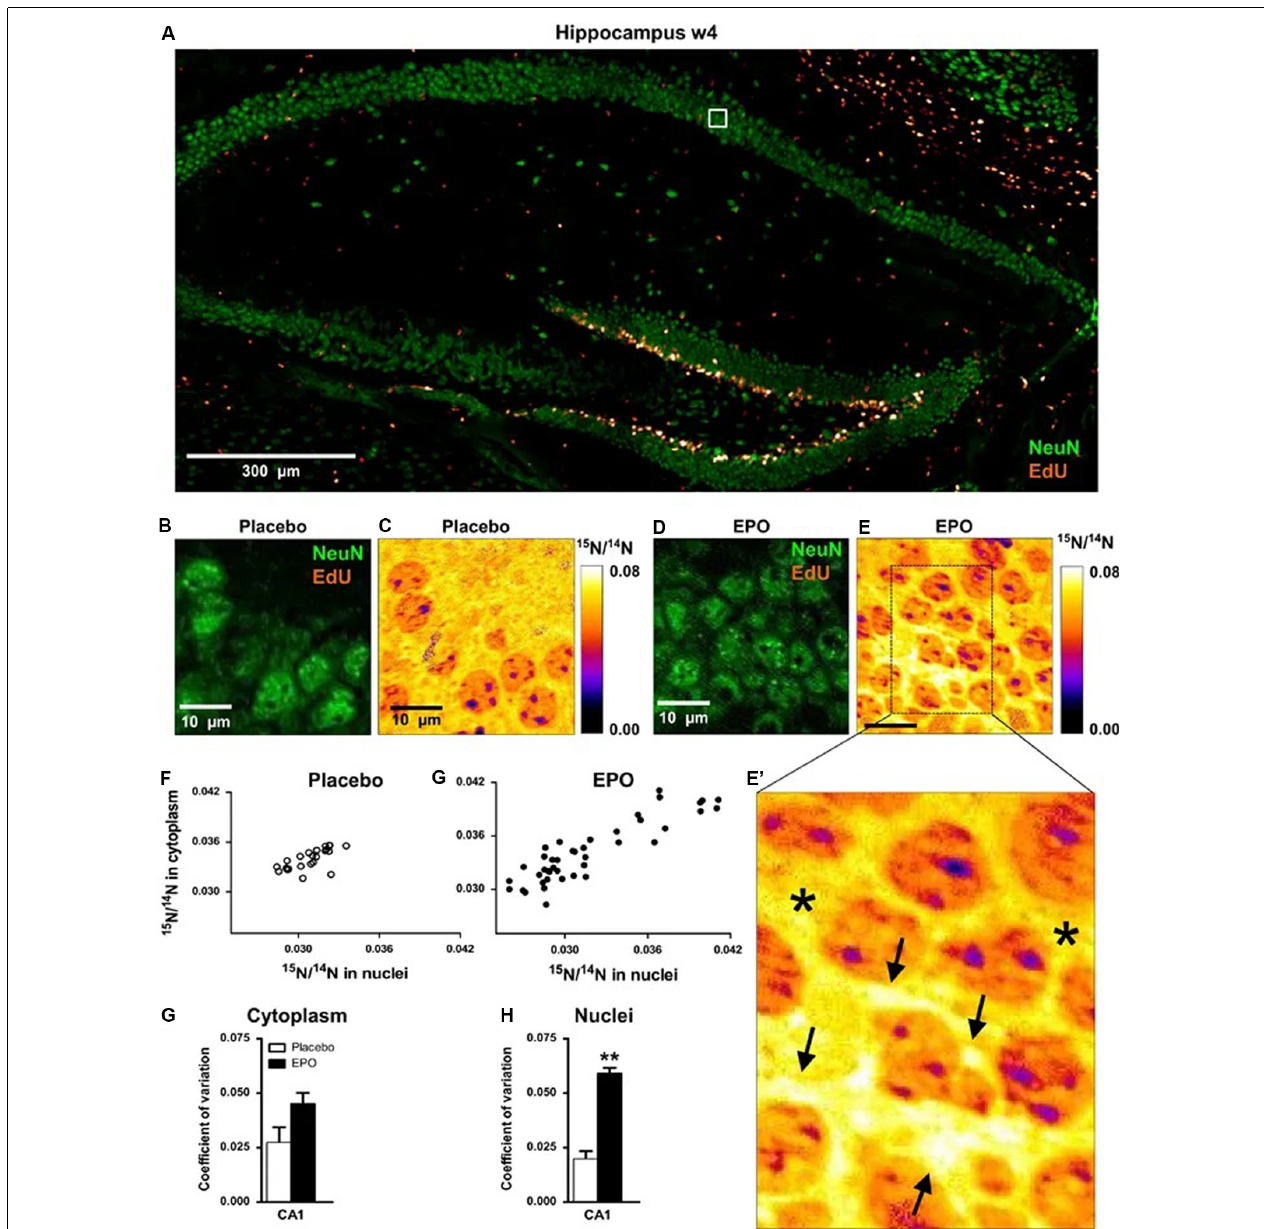
FIGURE 4 | 15 N-leucine incorporation in CA1 pyramidal neurons evaluated by NanoSIMS. (A) Overview of the hippocampus showing dense proliferation signals (EdU) in the dentate gyrus. The white square illustrates the EdU signal-free area in the pyramidal layer, analyzed by NanoSIMS. (B,C) Illustration of samples following placebo treatment; (D,E,E’) Illustration of samples following erythropoietin (EPO) treatment; arrows in panel (E’) point to newly generated neuronal cell mass with high 15 N/ 14 N ratio; stars in (E’) denote “control” signal in cytoplasmic regions of older neurons. (F,G) Scatter plots of 15 N/ 14 N ratios in pyramidal neurons in both treatment groups. (H,I) Coefficient of variation of 15 N/ 14 N ratios in cytoplasm and nuclei of pyramidal neurons ( n = 3 for both groups). All bar graphs are shown as mean ± s.e.m.; ** P < 0.01 (unpaired two-tailed t -test). 15 N incorporation appears higher in EPO-treated mice, indicating increased protein synthesis within pyramidal neurons treated with EPO. These observations thus show that EPO may contribute to central nervous system regeneration in adults, which may have behavioral and cognitive implications. Reproduced with permission from Hassouna et al.